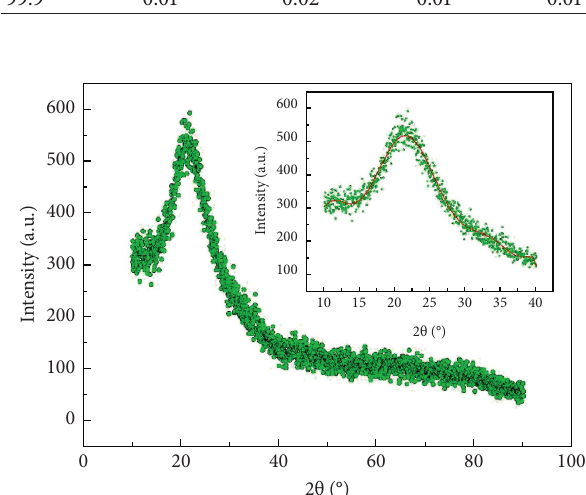
Figure 2: X-ray diffraction patterns of submicron high-purity SiO